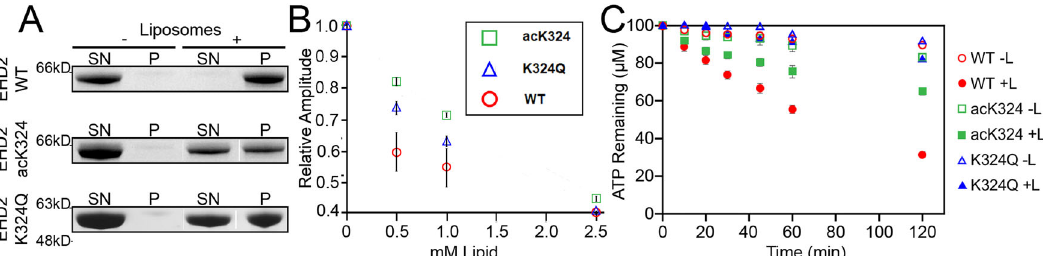
Fig. 3 Acetylation reduces EHD2 membrane binding and membrane binding af fi nity. A Co-sedimentation assays of EHD2-WT, EHD2-acK324 or EHD2- K324Q in the absence or presence of liposomes. SN, supernatant; P, pellet fraction. B mean of EPR spectral amplitudes plotted as a function of lipid concentration from EHD2-WT (red circle), EHD2-acK324 (green square) and EHD2-K324Q (blue triangle) spin-labeled at position 321. C ATP hydrolysis by EHD2-WT (red circle), EHD2-acK324 (green square) and EHD2-K324Q (blue triangle) in the presence ( fi lled marker) or absence (empty marker) of liposomes was determined by an HPLC-based method. Error bars represent the range (s.e.m.) of 3 – 6 independent experiments. Co-sedimentation was performed three times for EHD2-acK324 and twice for EHD2-K324Q with wild type controls in each independent experiment. Source data are provided as a Source Data fi le.